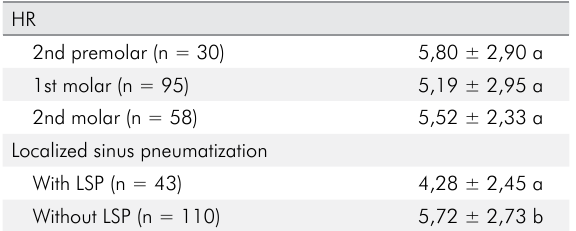
Table 2. Healed Ridge Height (HR) at edentulous sites (EdS) measurements according to tooth type and localized sinus